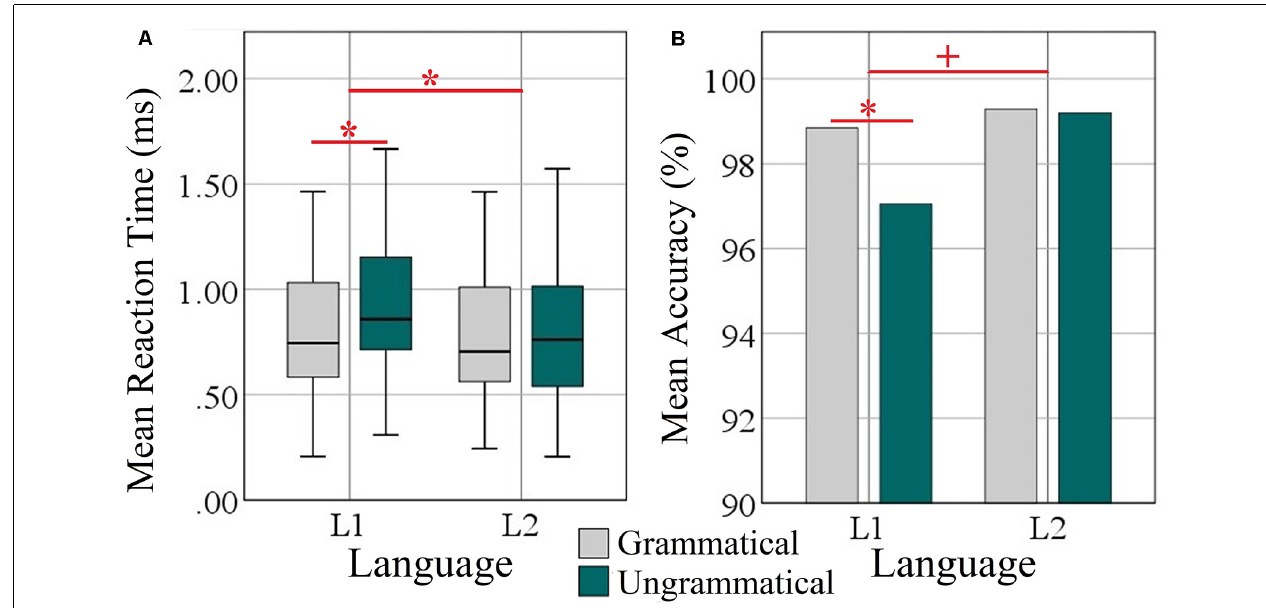
FIGURE 1 | Behavioral analysis of L1 (Turkish) and L2 (Persian). (A) Box plots of mean reaction time over grammatical and ungrammatical conditions per language in milliseconds. (B) Bar plots of mean accuracy as a percentage of correct answers over grammatical and ungrammatical conditions per language. Significant effects are indicated by the horizontal red bar; statistical difference (ANOVA and Post hoc two-tailed t-test) * p < 0.05. The plus sign denotes trends at p <